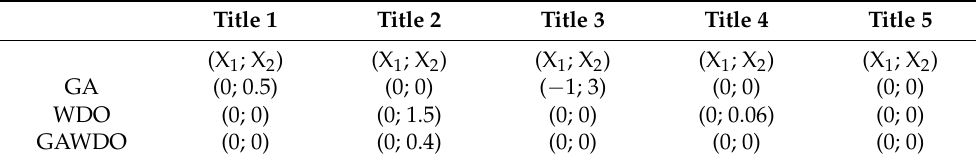
Table 2. Algorithm results on the Rastrigin function.